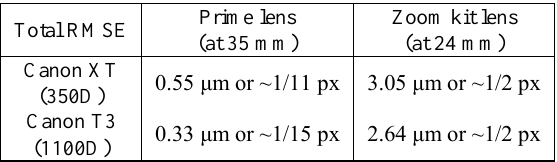
Table 2. RMSE of the residuals for the different calibration adjustments